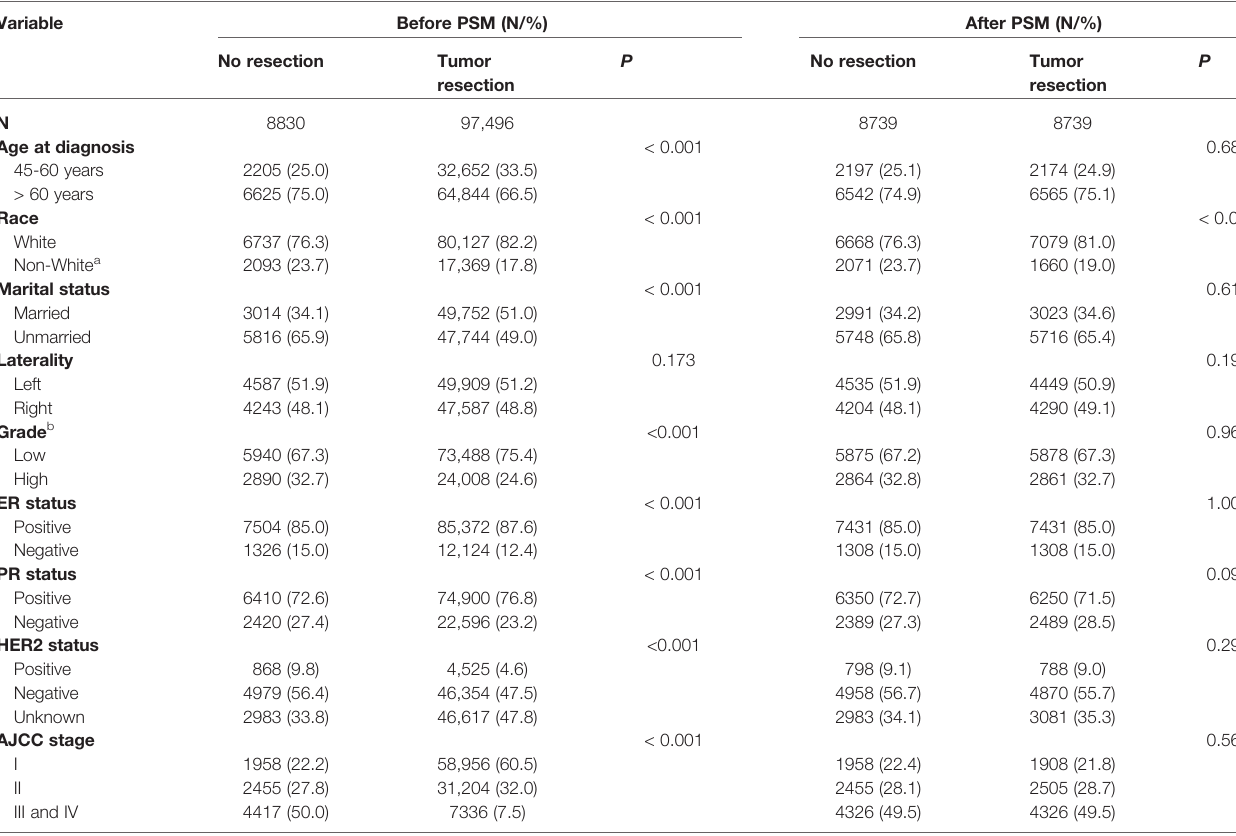
TABLE 1 | Baseline characteristics before and after propensity score